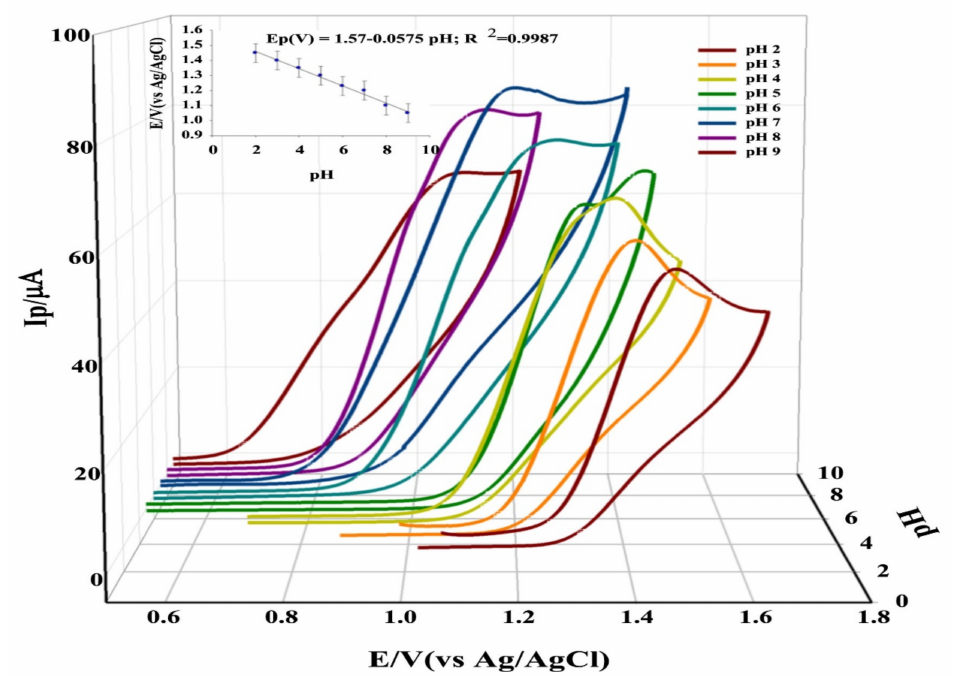
Figure 12. Cyclic voltametric responses of 1.0 mM COD at pH 2.0–9.0 using FSG/SPE sensing platforms at a scan rate of 0.1 V s − 1 . The inset displays the relation of IP versus pH. Reprinted by permission from [97]. Copyright 2018